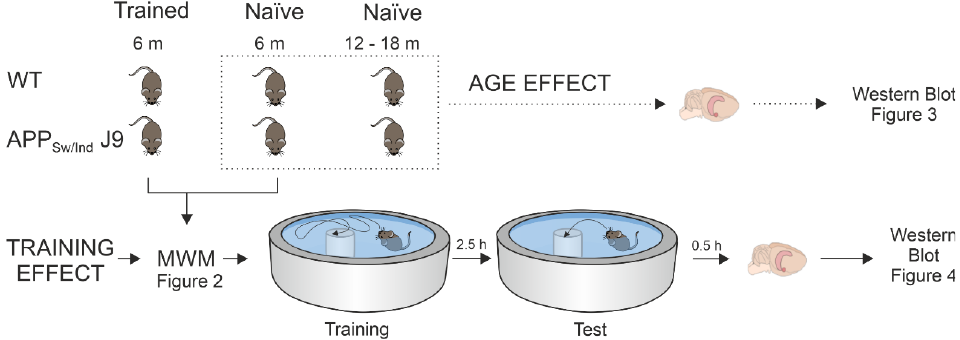
Figure 1. Experimental design showing number of animals for each condition, representation of training in the Morris Water Maze (MWM), hippocampal dissection for Western blot analysis, and corresponding figure numbers.